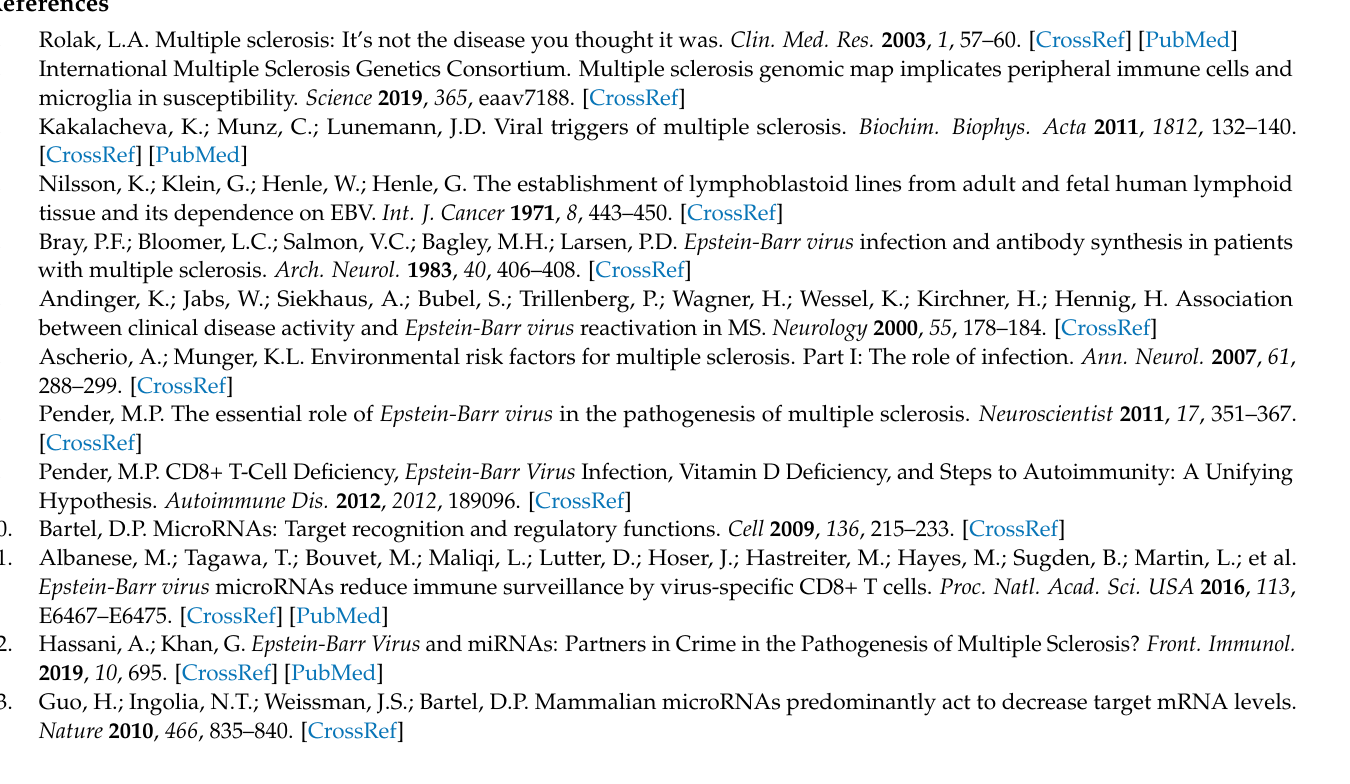
genes on the correlation between expression of cellular miRNAs and their targeted MS risk genes